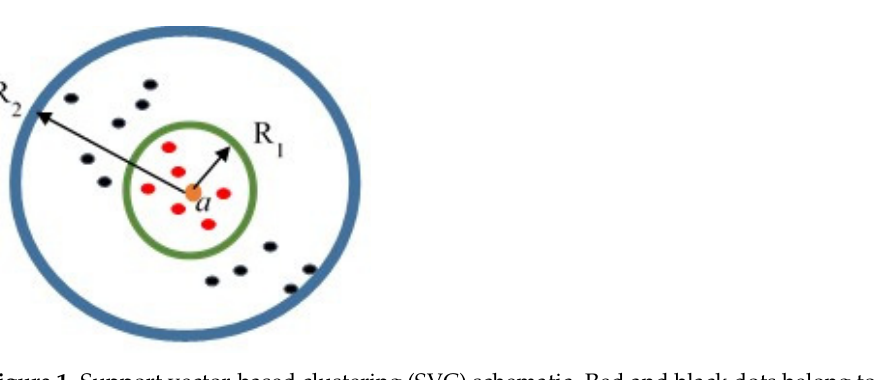
Figure 1. Support vector-based clustering (SVC) schematic. Red and black dots belong to cluster 1 and 2, respectively.